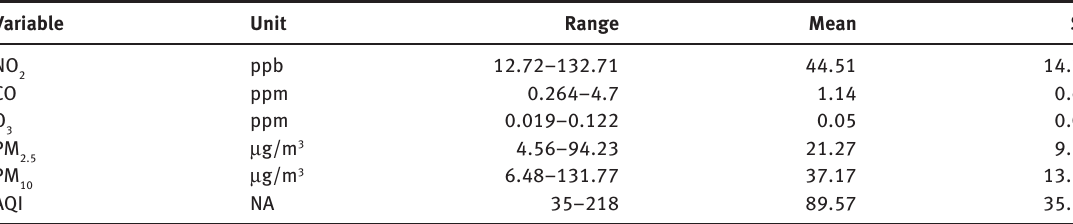
Table 3: Statistical Measures of Los Angeles Data Samples.